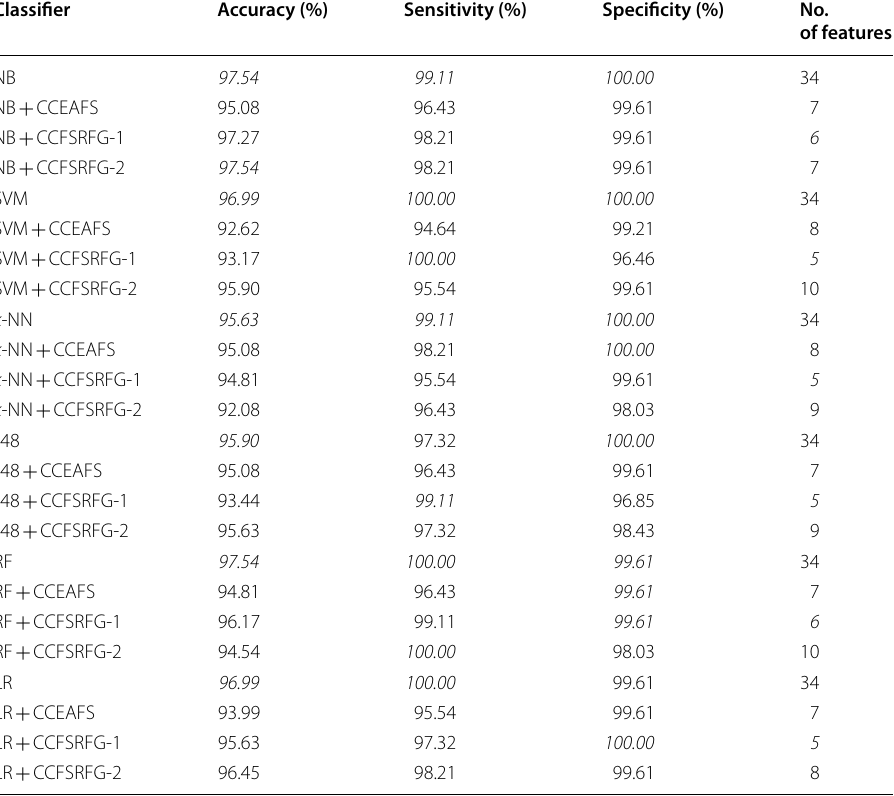
Table 8 Summary of results for the Dermatology